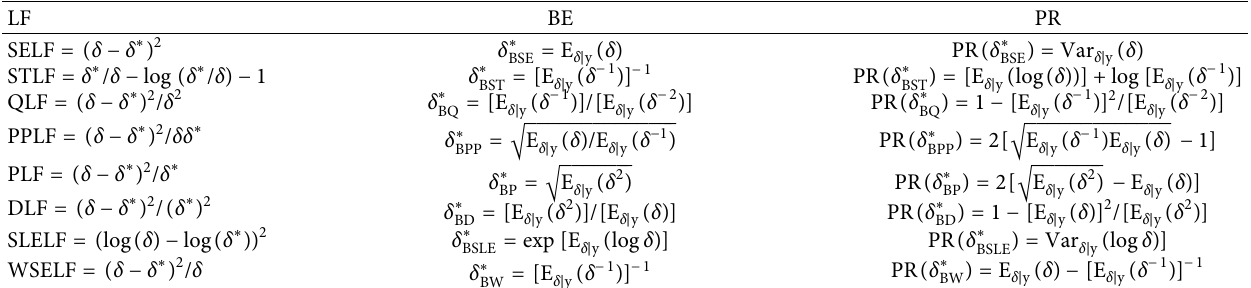
Table 1: LF, BE, and PR.